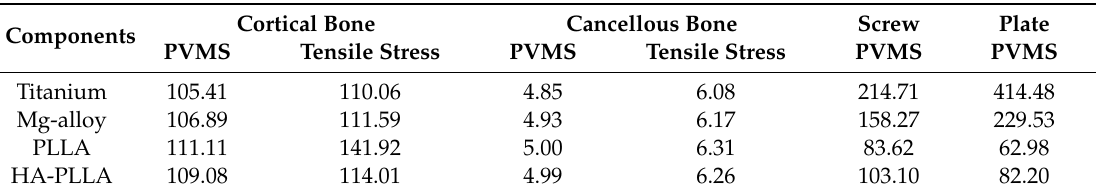
Table 2. The maximum peak von Mises stresses (PVMSs, MPa) and tensile stresses (MPa) for biological components and fixations according to the material at 132 N masticatory loading.